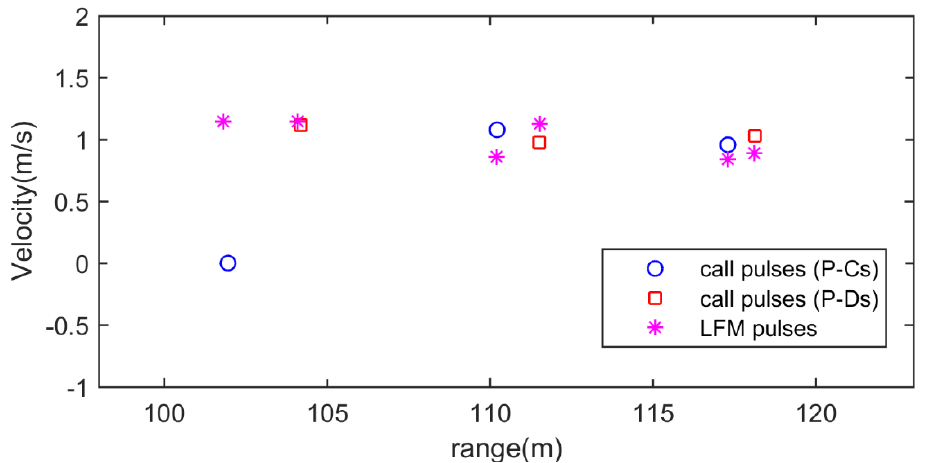
Figure 13. The estimated locus of ERs of range and velocity as time changes.